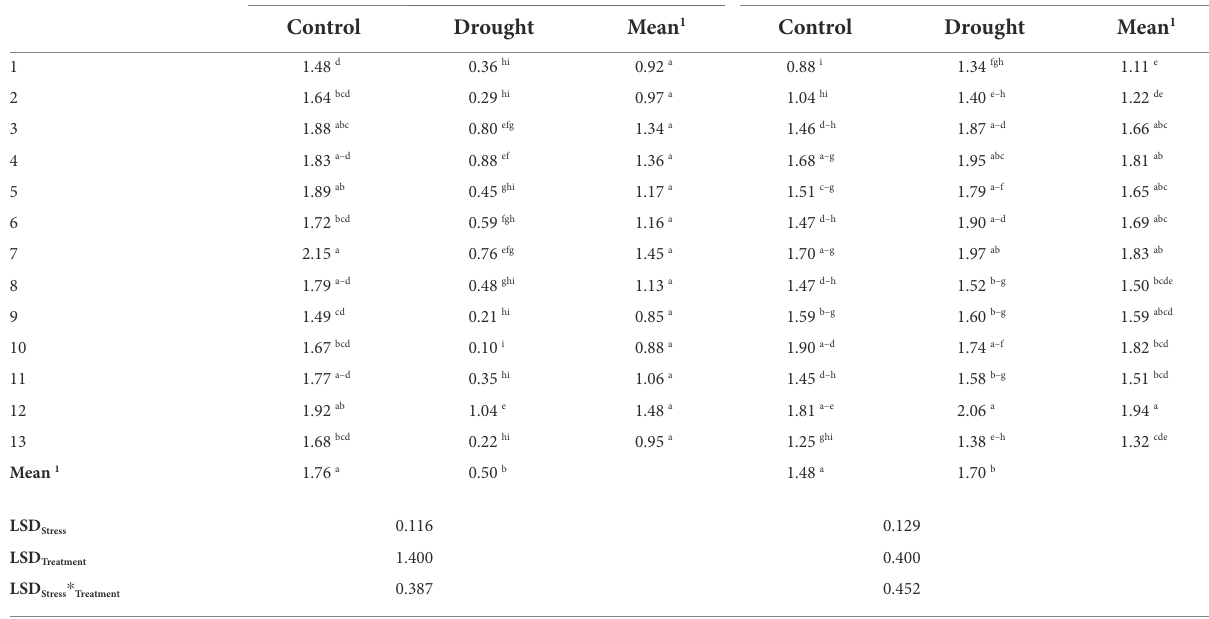
TABLE 5 The influence of the seed treatment and drought stress on transpiration rate – E (mmol/m 2 × s) during drought stress and after regeneration. Treatment